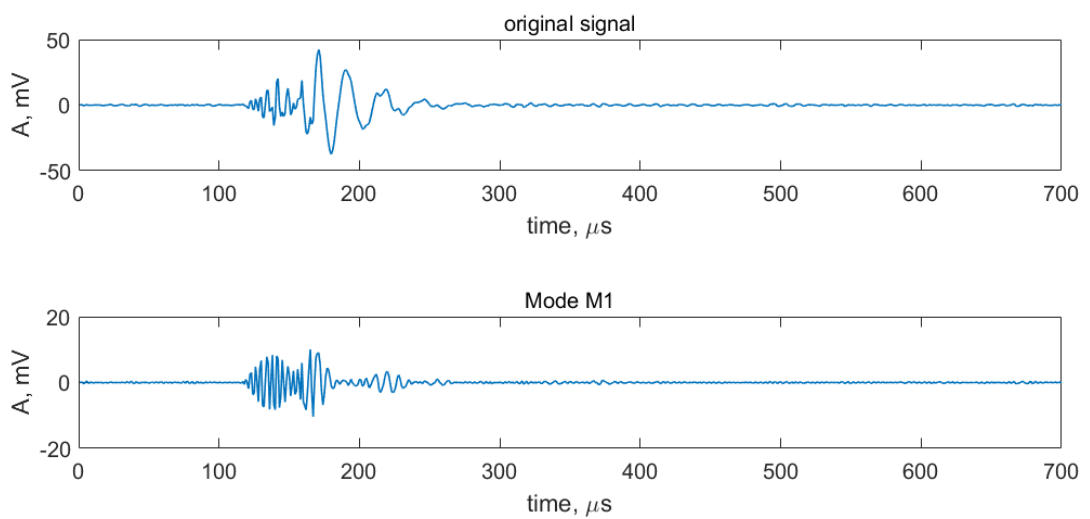
Figure 13. Example of the overlapping AE pulse and single background acoustic pulse ( a ) and the results of their overlapping ( b ).